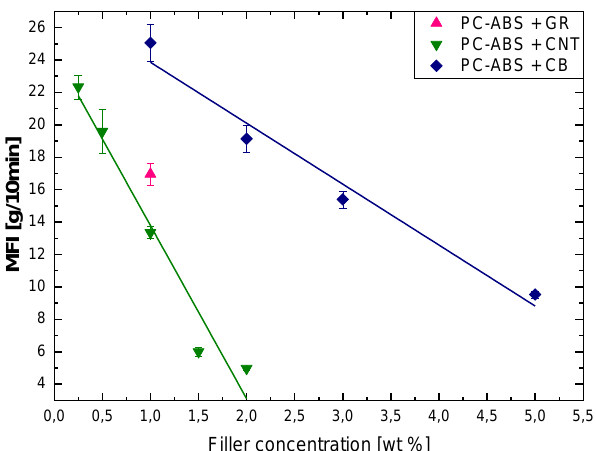
ff ect of filler concentration on the melt flow index (MFI) of the PC / ABS Figure 15. Effect of filler concentration on the melt flow index (MFI) of the PC/ABS composites. Figure 15. E